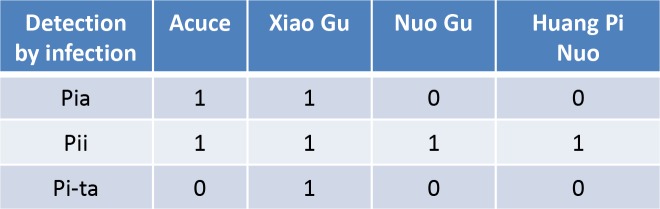
Estimation of the presence of the indicated Pi genes by inoculation with GUY11 transformed with the cognate Avr-Effector. “1” is presence (plant is resistant), “0” is absence of detection (plant is susceptible).